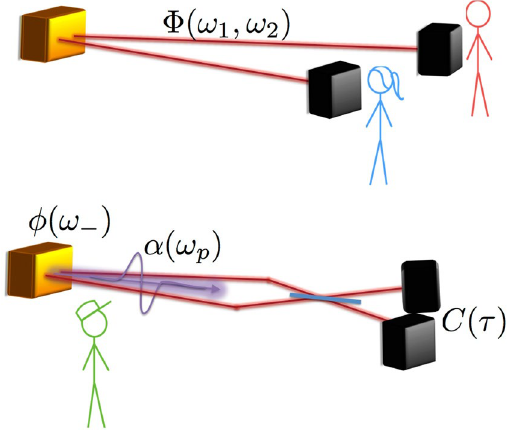
Figure 1. Conceptual layout of our analysis. In the common scenario, Alice and Bob need inferring entanglement in the joint spectral amplitude Φ ( ω 1 , ω 2 ) on the basis of local measurements. On the other hand, the handyman working on source development has access to information about the pump profile α ( ω p ), and can make the two modes interfere in a Hong-Ou-Mandel setup, thus inferring the approximated phase-matching function φ ( ω _ ) from the coincidence pattern C ( τ